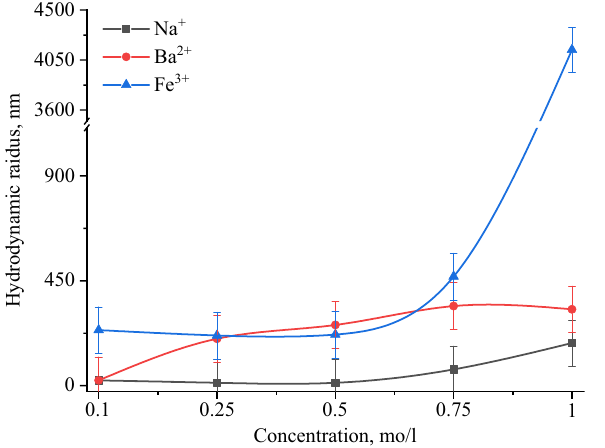
Figure 13. Dependencies of the average hydrodynamic radius of the negative Se NPs sol on the influence of Na + , Ba 2+ and Fe 3+ ions.